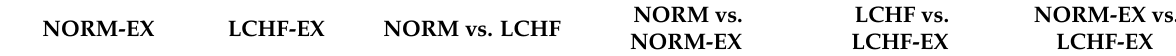
Table 2. Body composition at baseline and after the 10-week